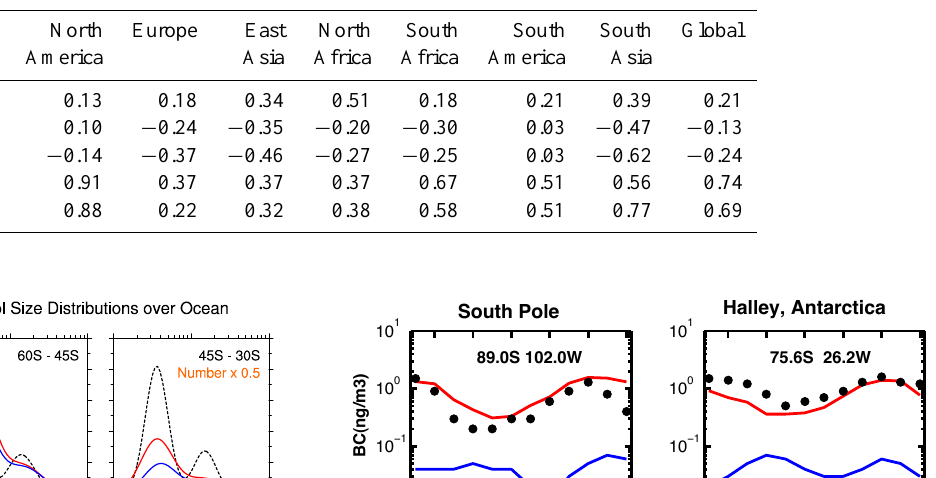
Table 4. Observed means, normalized mean biases ( b ) and correlation coefficients ( R ) between the model and observations for AOD over seven different regions (North America, Europe, East Asia, North Africa, and South Africa, South Asia) and the global. Monthly mean data is used. Observations are from the AERONET sites (http://aeronet.gsfc.nasa.gov/). See Fig. 22 in Wang et al. (2011) for the scatter plots of MMF results versus observations.